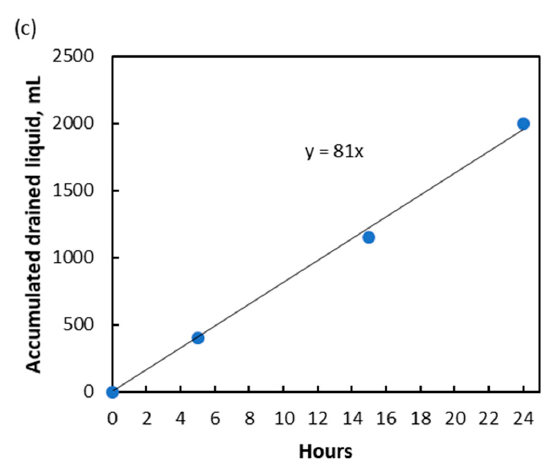
Figure 2. Continuous experiments with 26.0% CO 2 content in inlet gas. ( a ) Trend of treated gas CO 2 content; ( b ) Contact angle between solvent and membrane at various temperatures; ( c ) Accumulated drained liquid in knock-out drum with time.